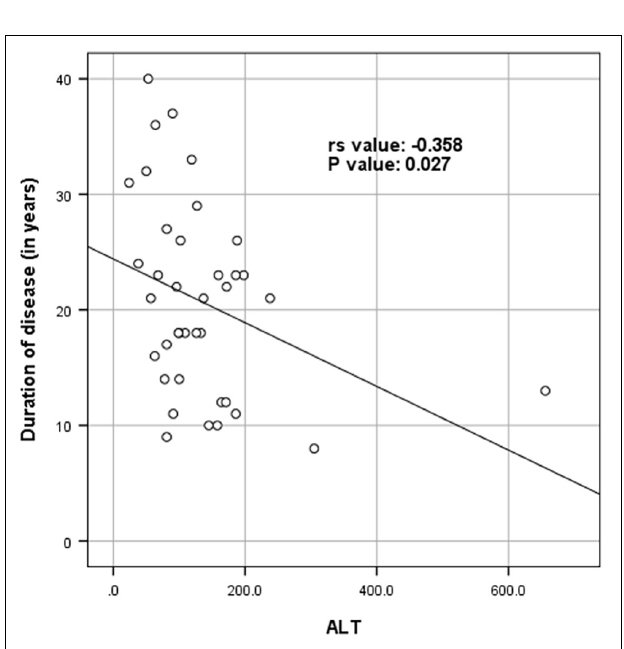
FIGURE 6 | Scatter plot diagram of correlation between duration of disease (in years) and ALT ( N =